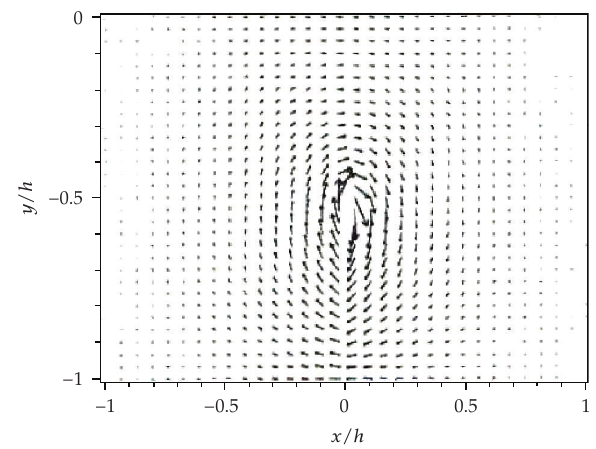
Figure 5: The local disturbances h (cid:8) 20cm, l (cid:8) 10cm, and ε (cid:8) 0 . 6